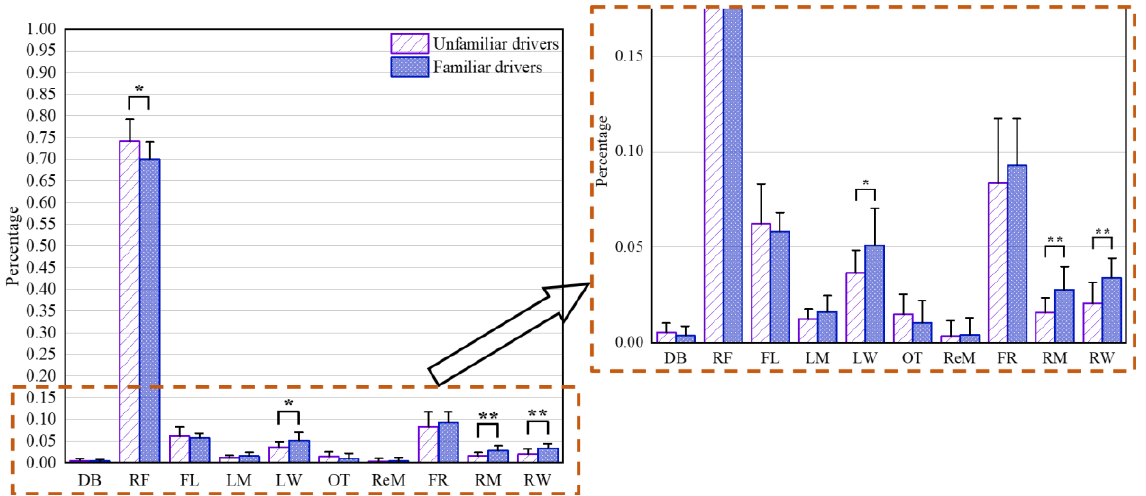
Figure 7. Percentages of the number of fixations at each AOI at urban intersections for unfamiliar drivers and familiar drivers. * denotes significance at the 0.05 level ( p ≤ 0.05). ** denotes significance at the 0.01 level ( p ≤ 0.01). RF refers to right front, FL refers to front-left, FR refers to front-right, LW refers to left window, LM refers to left mirror, RW refers to right window, RM refers to right mirror, ReM refers to rearview mirror, DB refers to dashboard and OT refers to